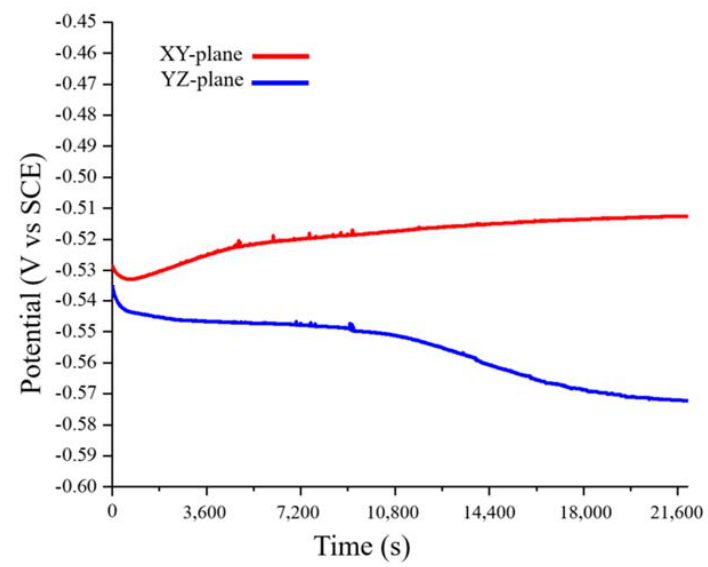
Figure 6. Open circuit potential (vs. SCE) of the LMD HEA in 0.1 M H 2 SO 4 at 25 °C.